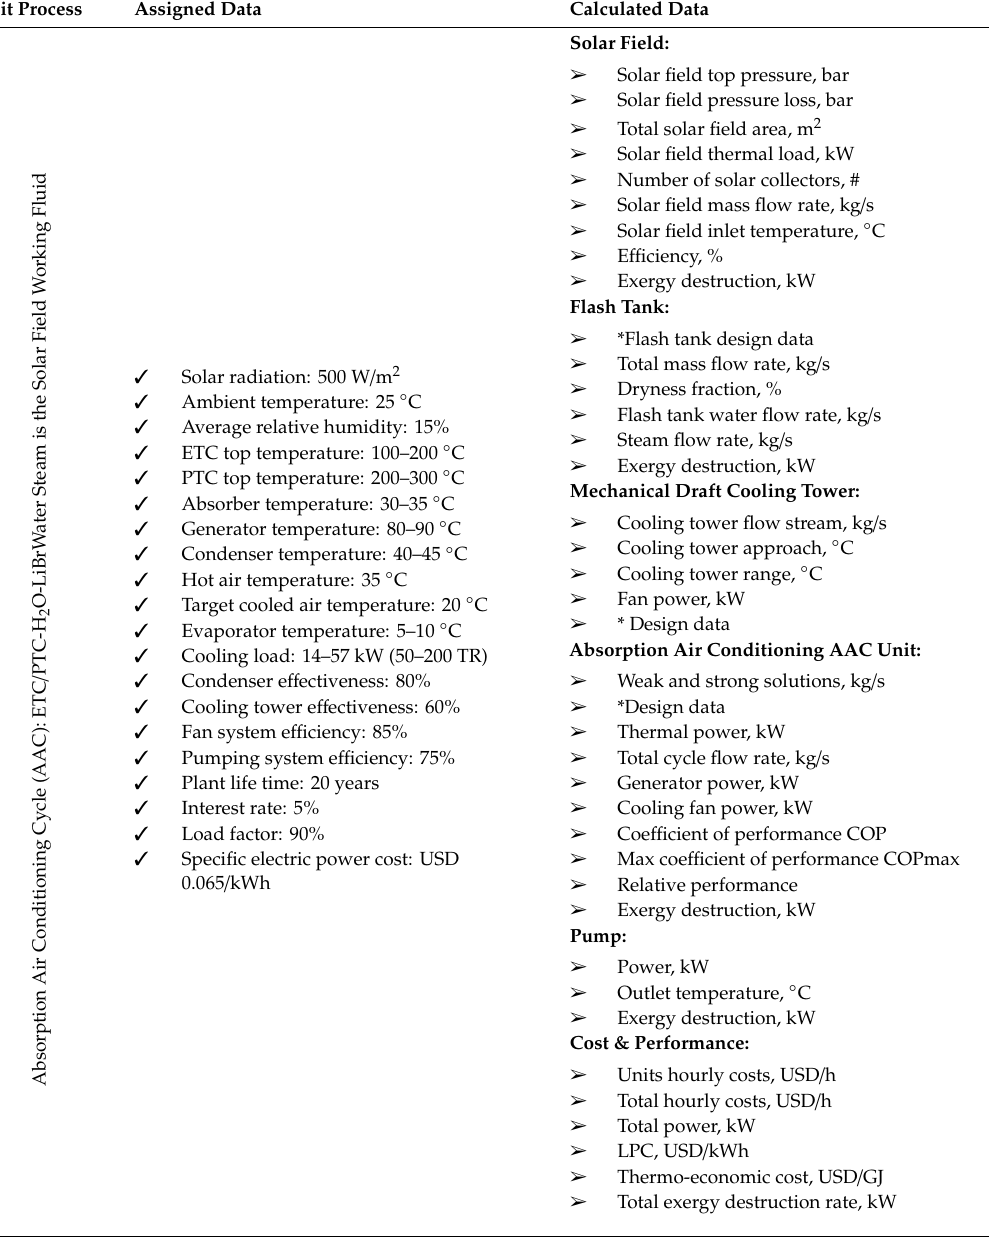
Table 1. Assumptions for the ETC / PTC-H 2 O / LiBr